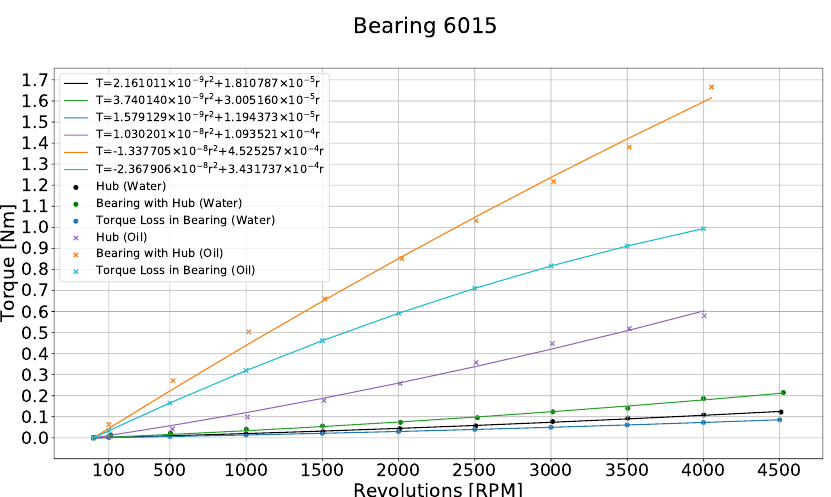
Figure 7. Bearing 6015—Torque losses in water and